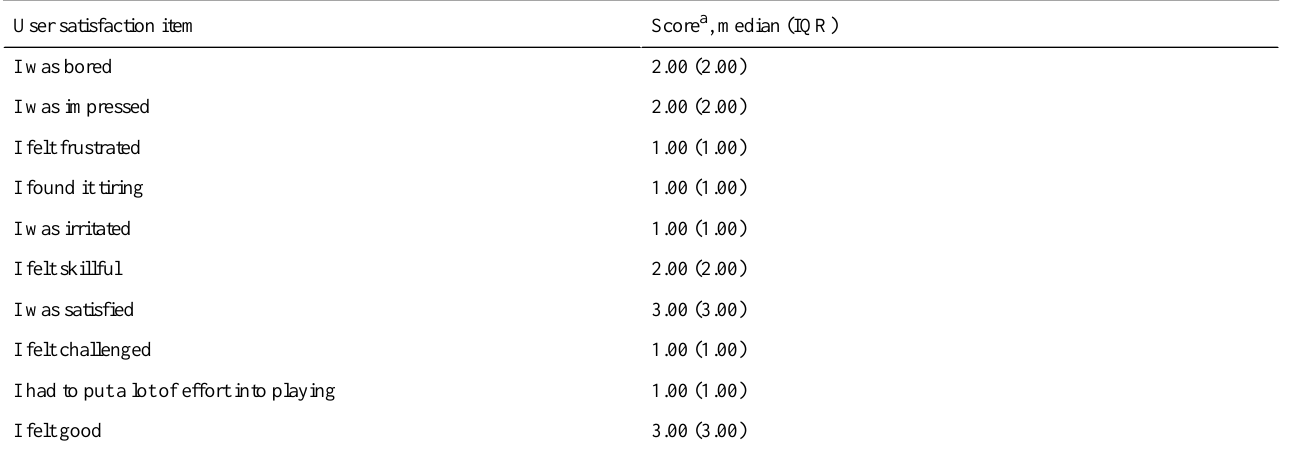
Table 2. User satisfaction of the mobile